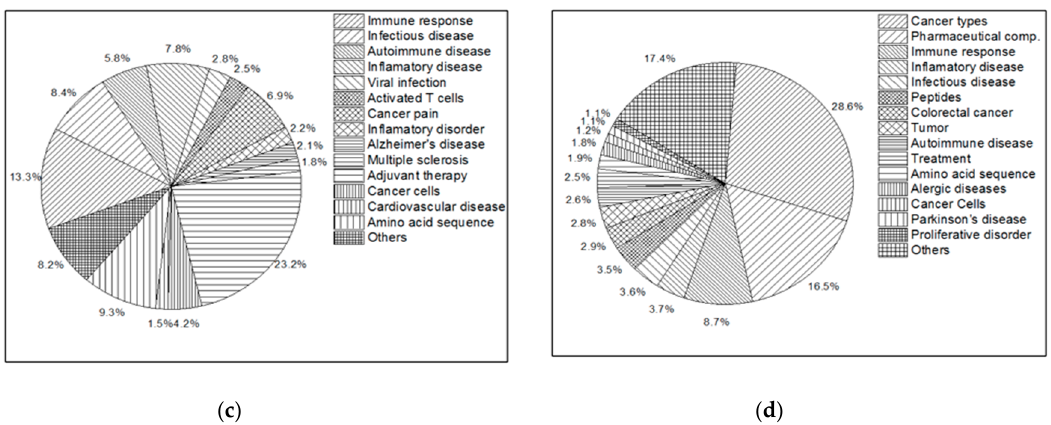
Figure 3. Keyword and title phrase groups in the latest papers and patents up to 31/12/2018; ( a )